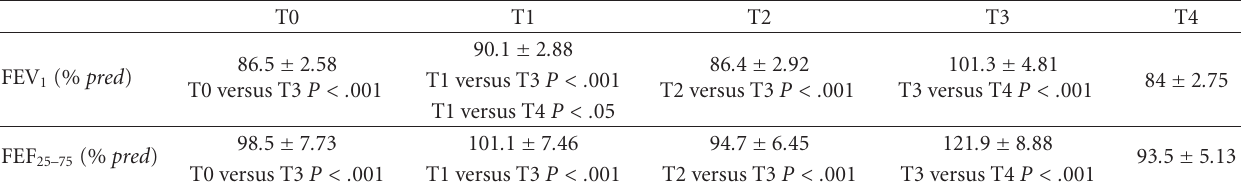
Table 1: Mean ( ± SEM) lung function data and p